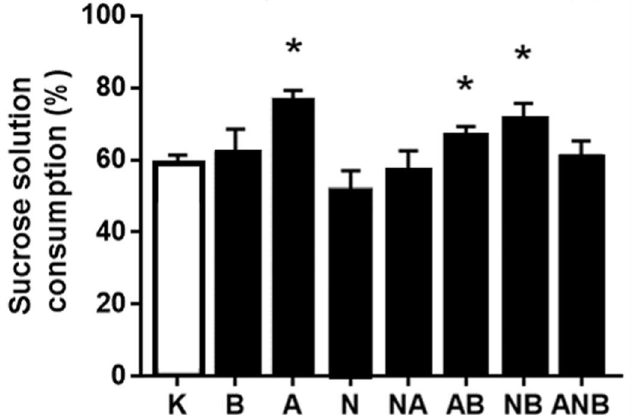
Figure 10. Sucrose solution consumption day 3 (%). Ketamine-induced sucrose consumption is shown in the sucrose preference test (SPT), mean values, and 95 percent confidence intervals. Su- crose preference testing was continued after the open field test (OFT) for 72 h. In the ketamine rats (30 mg/kg ip), medication (mg/kg ip) was: L-NAME (5) (N), L-arginine (100) (A), BPC 157 (0.01) (B), alone and/or together (L-NAME+L-arginine (NA), L-arginine+BPC 157 (AB), L-NAME+BPC 157 (NB), L-arginine+L-NAME+BPC 157 (ANB)), and saline 5 mL/kg ip (control ketamine) (K). The ap-